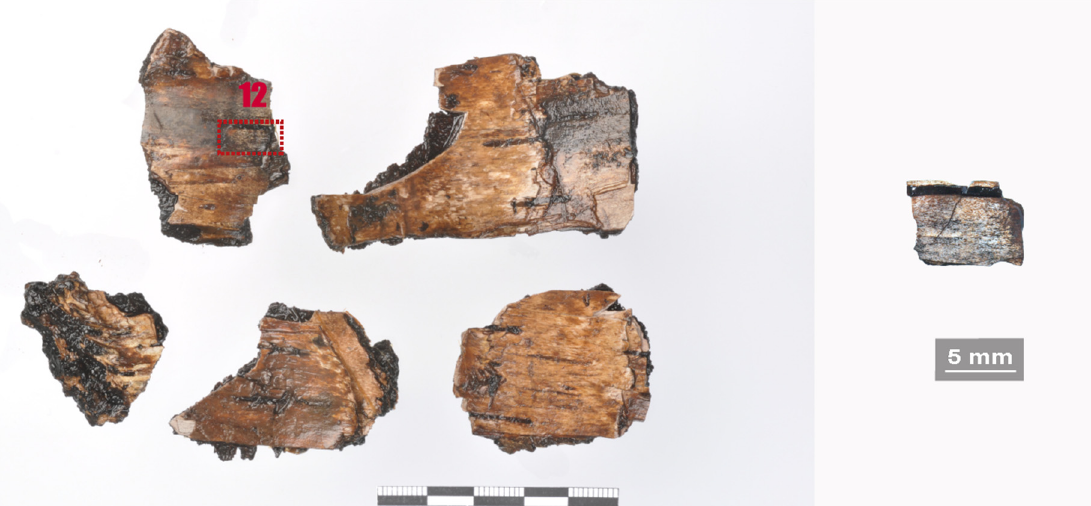
Figure 6. Left: birch bark fragments from Lake Moosee (521 m a.s.l) were recovered during an excavation in 2011 from a waterlogged sediment. Small, waterlogged fragments floating on water retain phloem, indicating that they were not harvested from the tree but detached naturally. During cutting, many fractures occurred, and small pieces broke off. Right: sample 12 does not have original white colour apart from a fresh fracture with splintered surface. Inner bark has dark-brown colour and is very brittle, and lenticels are not well defined and have frayed edges.